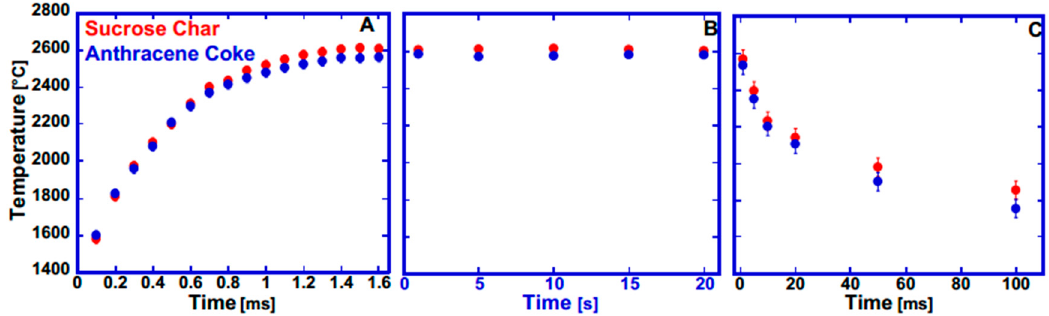
Figure 8. ( A ) Heating rates; ( B ) temperature stability during laser pulse ( C ) and cooling rates for anthracene coke and sucrose char heated with CO 2 laser radiation.